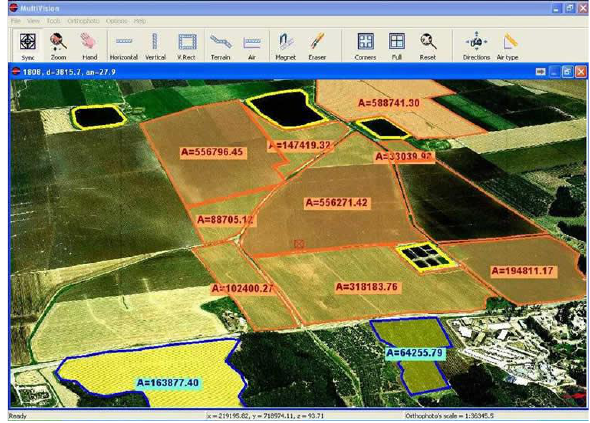
Figure 6. Parcel area measurements (Aeromap,